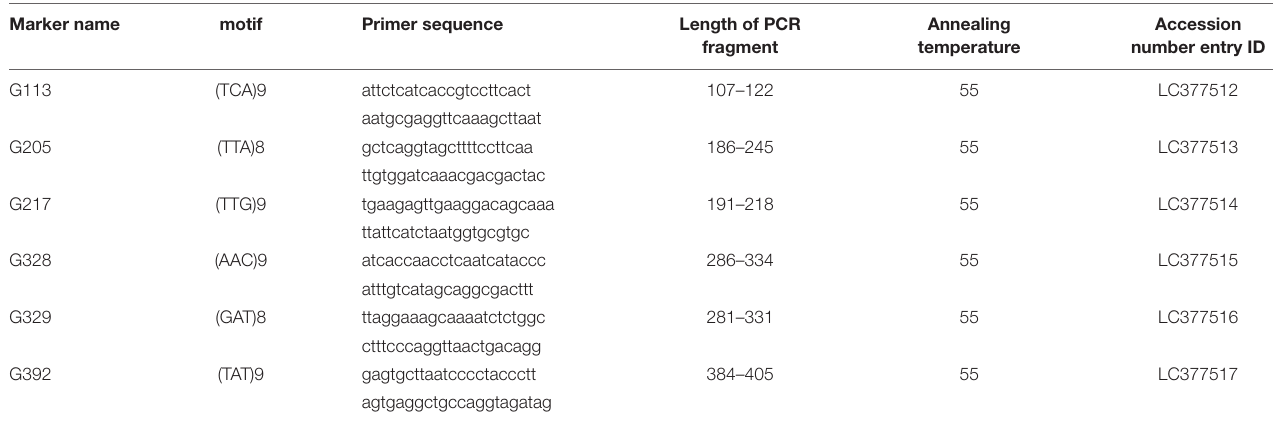
TABLE 2 | Microsatellite markers of Goniopora spp. developed in this